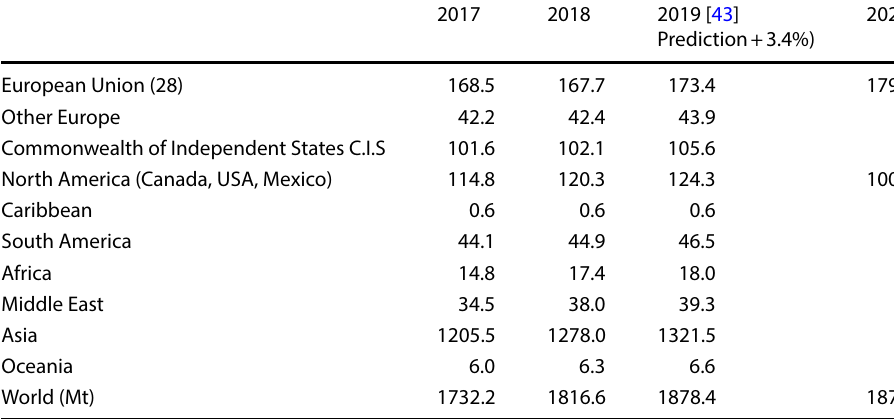
Table 8 Global crude steel production data by country (million